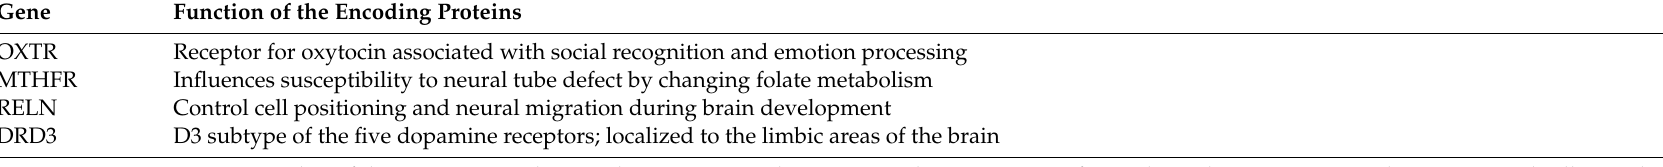
Table 5. Lists of genes involved in the PPI